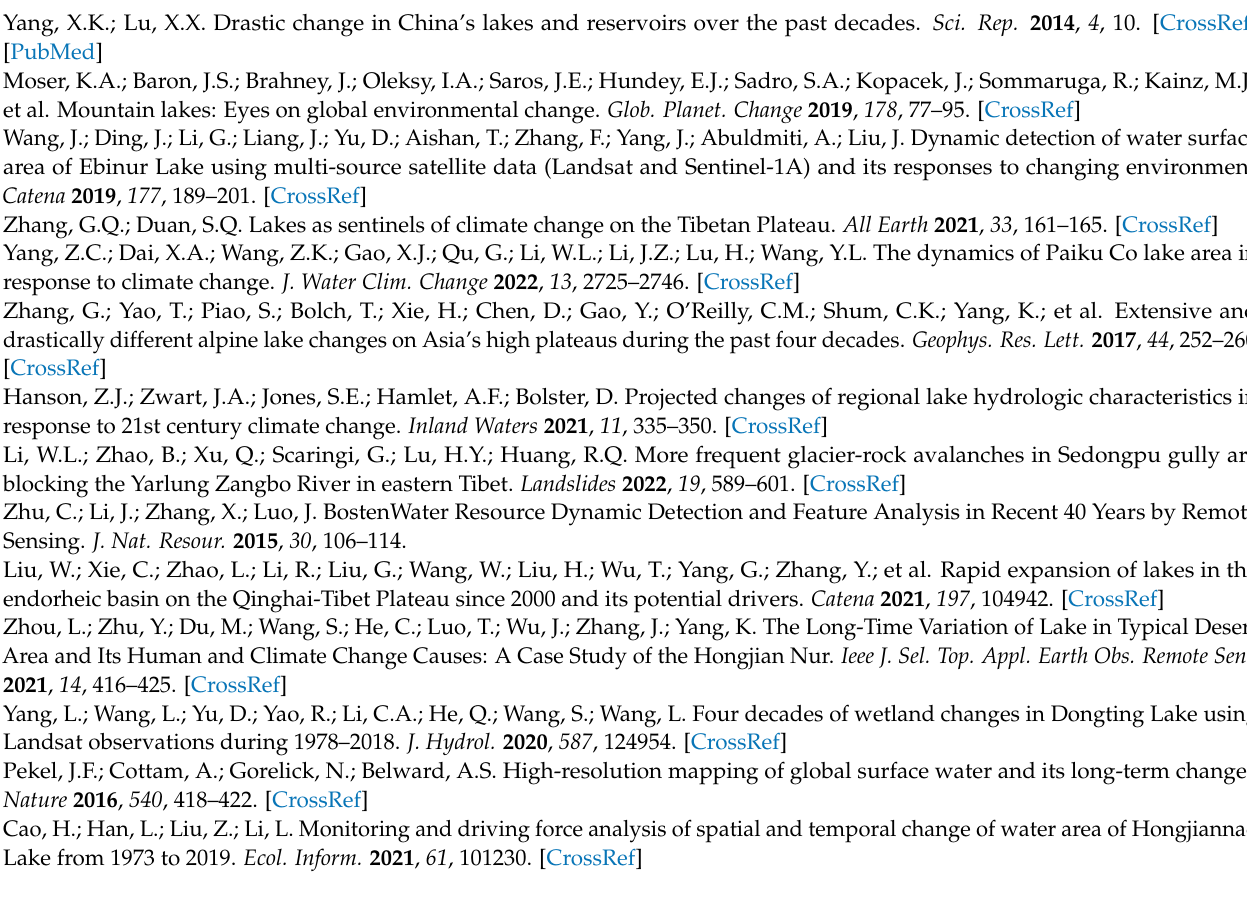
Figure S5: Information on the water bodies of Ma Lake in the dry season from 2000 to 2020; Figure S6: Information on the water bodies of Ma Lake in the rainy season from 2000 to 2020; Figure S7: Information on the water bodies of Three Forks Lake in the dry season from 2000 to 2020; Figure S8: Information on the water bodies of Three Forks Lake in the rainy season from 2000 to 2020; Figure S9: Information on the water bodies of Luban Reservoir in the dry season from 2000 to 2020; Figure S10: Information on the water bodies of Luban Reservoir in the rainy season from 2000 to 2020; Figure S11: Information on the water bodies of Shengzhong Reservoir in the dry season from 2000 to 2020; Figure S12: Information on the water bodies of Shengzhong Reservoir in the rainy season from 2000 to 2020; Figure S13: Land cover distribution around Lugu Lake from 2000–2019; Figure S14: Land cover distribution around Qionghai Lake from 2000–2019; Figure S15: Land cover distribution around Ma Lake from 2000–2019; Figure S16: Land cover distribution around Three Forks Lake from 2000–2019; Figure S17: Land cover distribution around Luban Reservoir from 2000–2019; Figure S18: Land cover distribution around Shengzhong Reservoir from